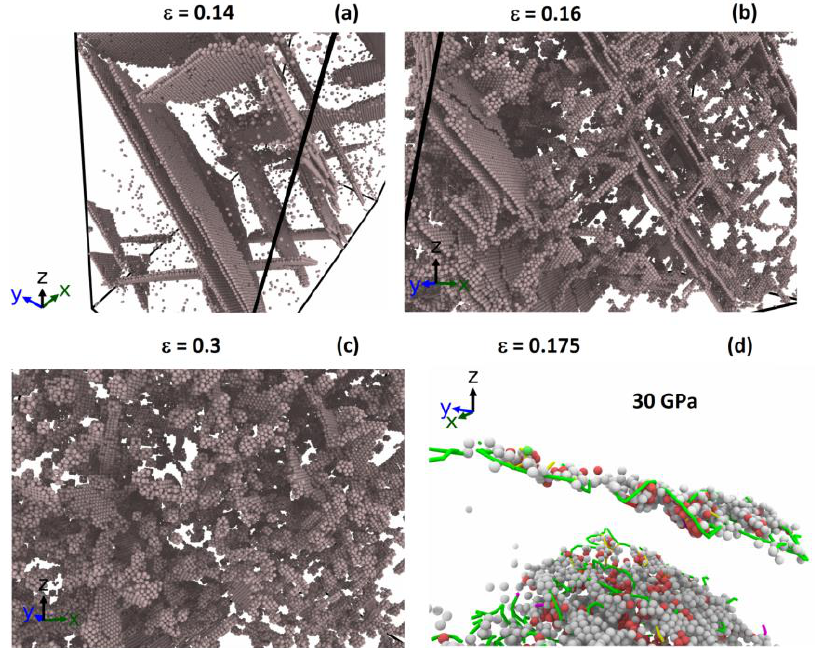
Figure 10. Development of plastic deformation in aluminum at an initial pressure of: ( a , b , c ) 0 GPa and ( d ) –30 GPa. ( a ) Growth of loops of partial dislocations limiting stacking faults; ( b ) generation of secondary perfect dislocations from intersections of the stacking fault planes; ( c ) dense disloca- tion network and a large number of vacancies. ( d ) Simultaneous nucleation of a large number of dislocation loops lying on different slip planes.